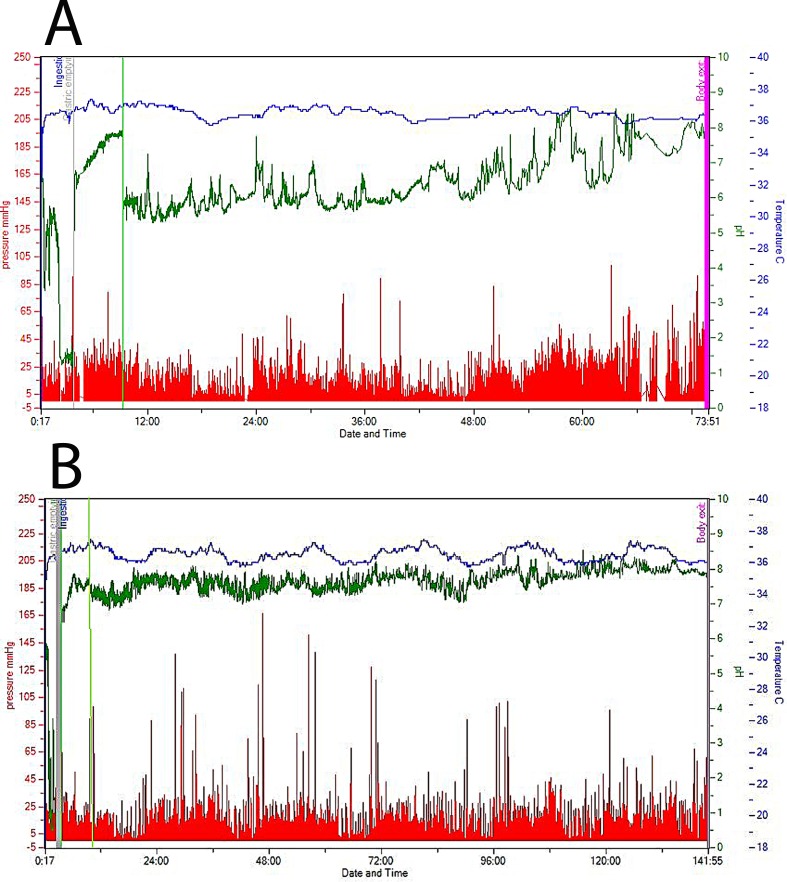
A summary of WMC (wireless motility capsule) data.The blue line represents the temperature, the green the pH and the red peaks the pressure along the entire gut. The green vertical lines display the ileocoecal transition zone. In 1A (Healthy Control) the pH drop is more than 1 unit, in 1B (FGDS) the characteristic pH drop in the ileocoecal junction is not present. This was found in 6 FGDS patients.